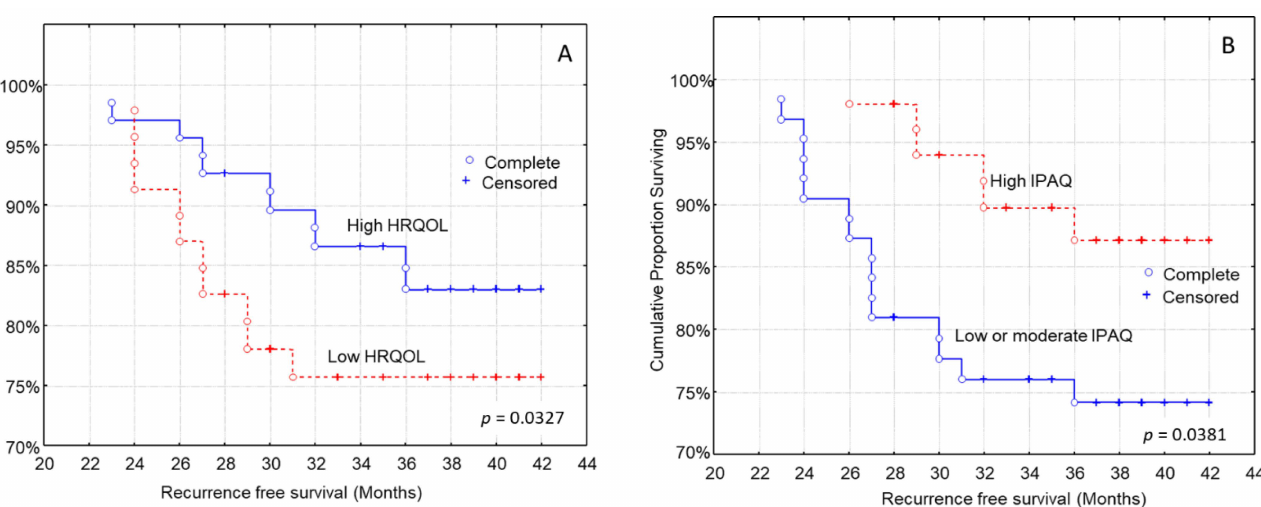
Figure 3. Kaplan–Meier survival analysis stratified according to ( A ) health-related quality of life (HRQOL) and ( B ) international physical activity questionnaire (IPAQ) in 114 breast carcinoma patients for recurrence-free patients’ survival.